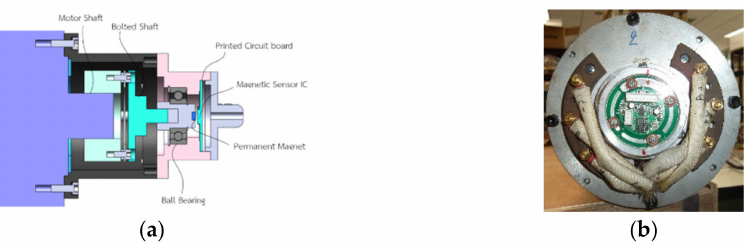
Figure 16. Rotor position detection system: ( a ) mechanical coupling device; ( b ) a constructed rotor position detection system installed on the three-phase 6/4 pole SRM.